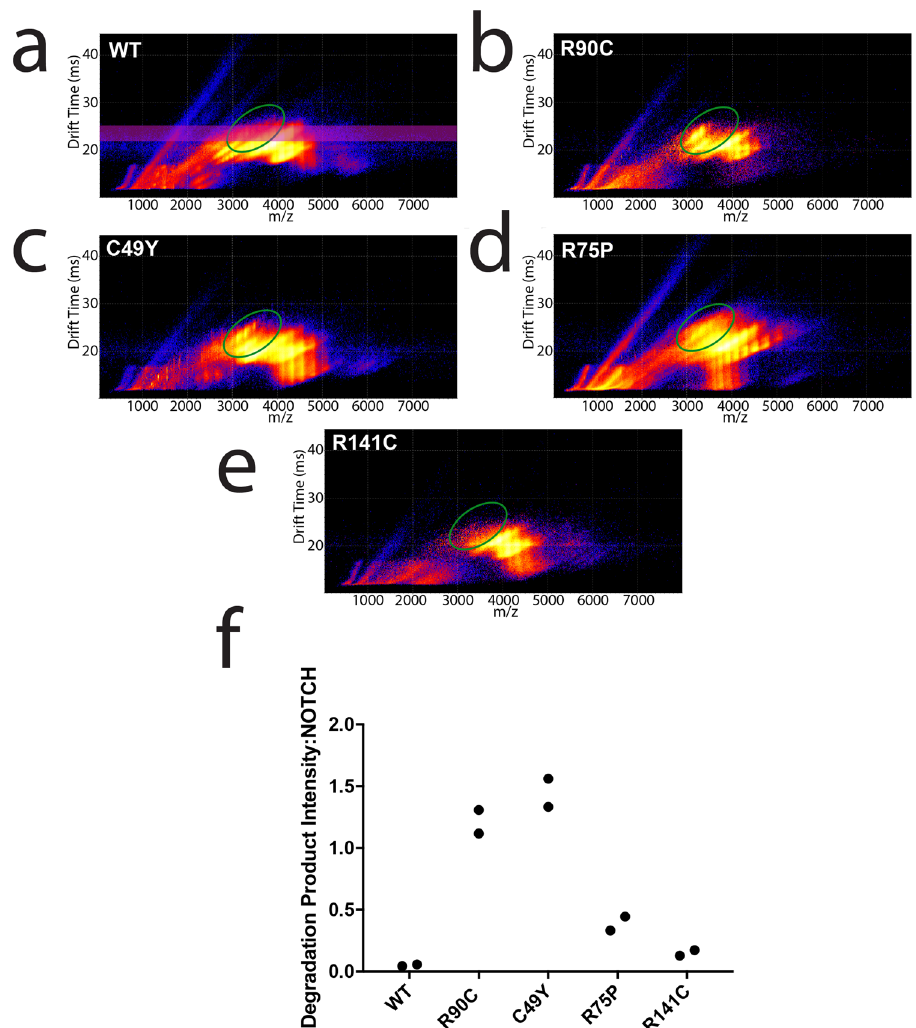
Fig. 6 IM-MS identi fi es a population of degradation products in selected mutants. IM-MS plots from two experimental replicates demonstrated the presence of an entity appearing at 100 V for R90C, C49Y, and R75P mutant proteins ( a – e , green circle). Investigation of WT and R141C protein failed to qualitatively identify this population. Further analysis of the C49Y mutant protein revealed an approximate mass of 55 kDa, smaller than the theoretical 86 kDa size of the puri fi ed Fc-fusion proteins. This degradation product was absent at lower voltages for all constructs (Fig. S6). Quanti fi cation of degradation product intensity relative to intact construct calculations is displayed in ( f ). By extracting the IM region of 22 – 25 ( a , pink bar) both the degradation product and intact NOTCH3 intensities were extracted. Increased amounts of degradation product were observed in the R90C, C49Y, R75P, and R141C mutants ( f ). The ratio of degradation product to intact NOTCH3 was lowest for WT